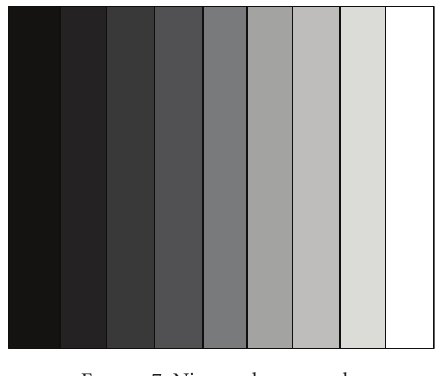
Figure 7: Nine-scale gray scale.